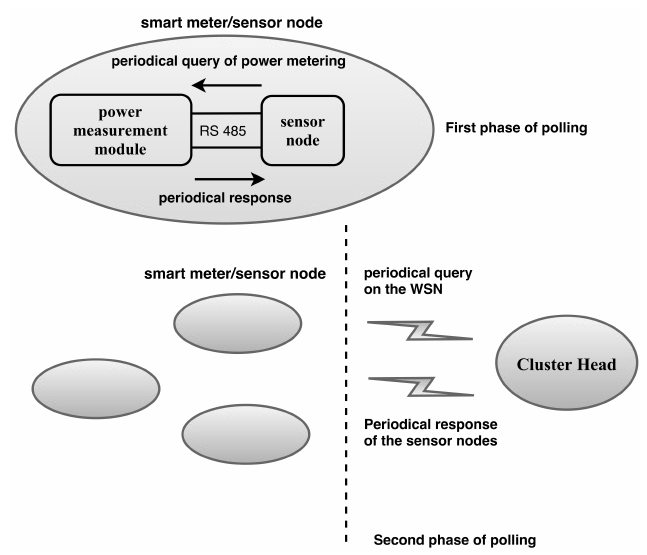
Figure 4. Diagram of WSN communication with two levels of